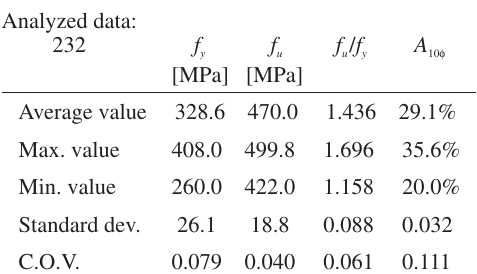
Table IV. Mechanical properties of steel Aq. 42 in the decade